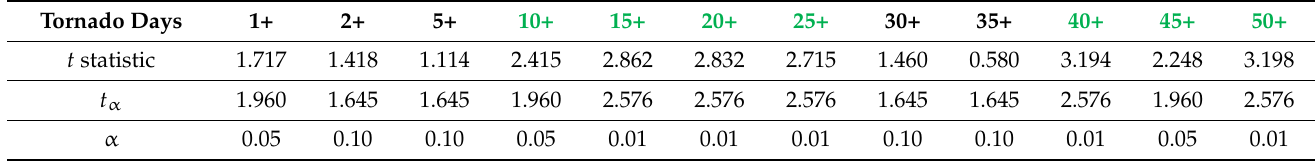
Figure 7. ( a ) Number of 20+ tornado day (in orange) and composites of surface air temperature anomaly (°C) over the time period of 1959 to 1988, and ( b ) number of 20+ tornado day (in blue) and composites of surface air temperature anomaly (°C) over the time period of 1989 to 2018. Table 2. t test for U.S. tornado days (statistical significance denoted by green colors).